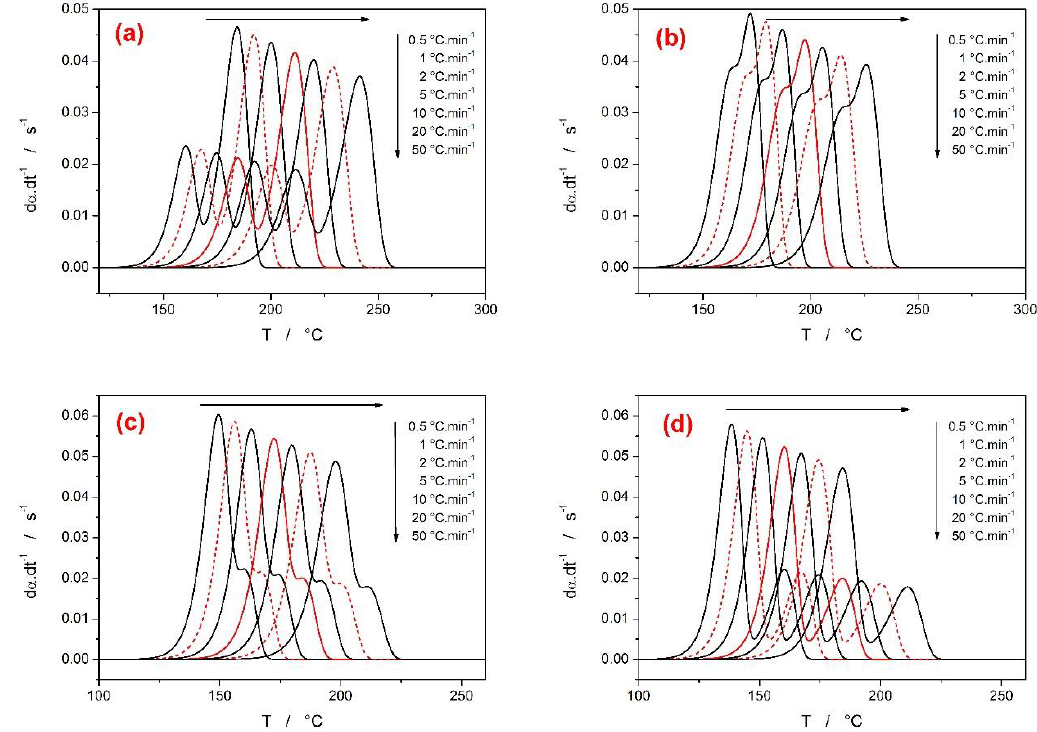
Figure 2. Second sub-group of base sets of simulated data; the simulations were performed with 10,000 points / curve density. The kinetic parameters are listed in Table 1. Each graph depicts set of seven complex kinetic curves simulated for the heating rates 0.5, 1, 2, 5, 10, 20, and 50 ◦ C · min − 1 . ( a ) set D; ( b ) set E; ( c ) set F; ( d ) set G. Table 1. Kinetic parameters used to simulate the datasets within the first group of scenarios.